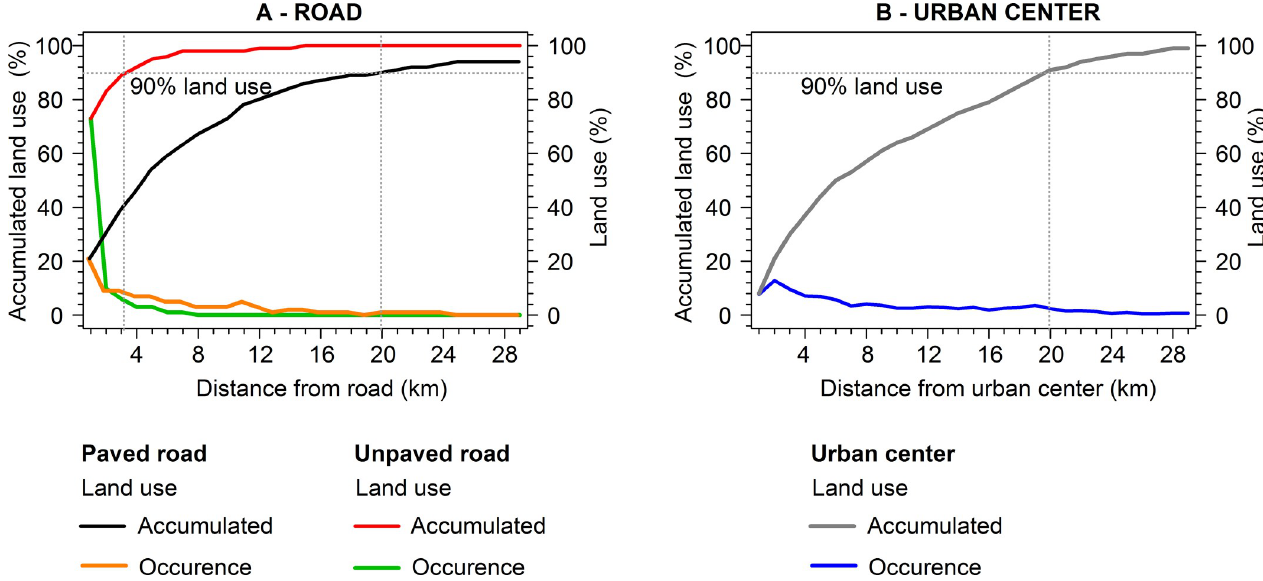
Fig 7. Accumulation of mangrove land use in relation to the distance from anthropogenic drivers. A) Accumulated mangrove land use (left axis) in relation to paved (black lines) and unpaved (red lines) roads. Percentage mangrove land use (right axis) in relation to paved (orange lines) and unpaved (green lines) roads. B) Accumulated mangrove land use (left axis) in relation to urban centers (gray lines). Percentage mangrove land use (right axis) in relation to urban centers (blue lines). The gray dashed line indicates the distance within which 90% of mangrove land use was registered in relation to paved roads and urban centers (20 km), and unpaved roads (3 km).